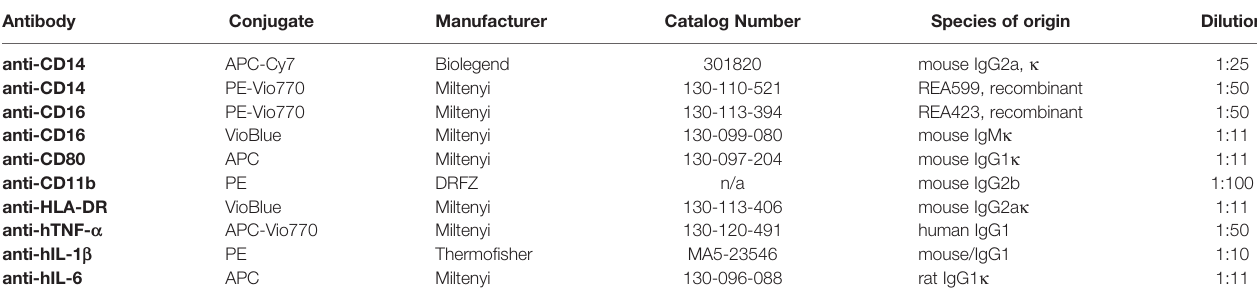
TABLE 1 | Antibodies used for fl ow cytometry. Antibody